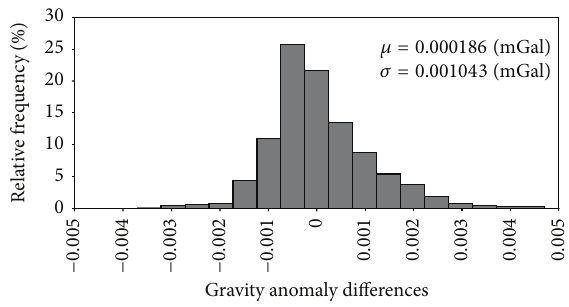
Figure 14: Relative frequency distribution of residuals shown in Figure 13, including mean and standard deviation values.